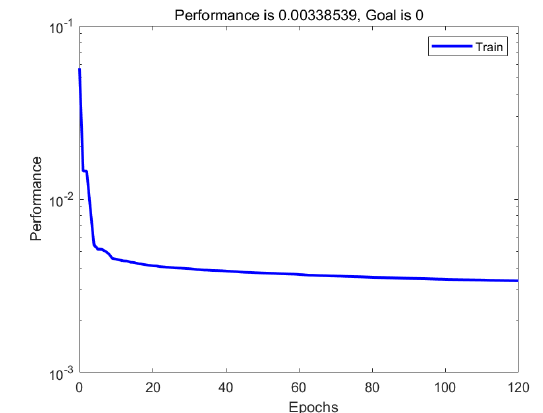
Figure 8. Mean square error (MSE) curve during RBF neural network training.